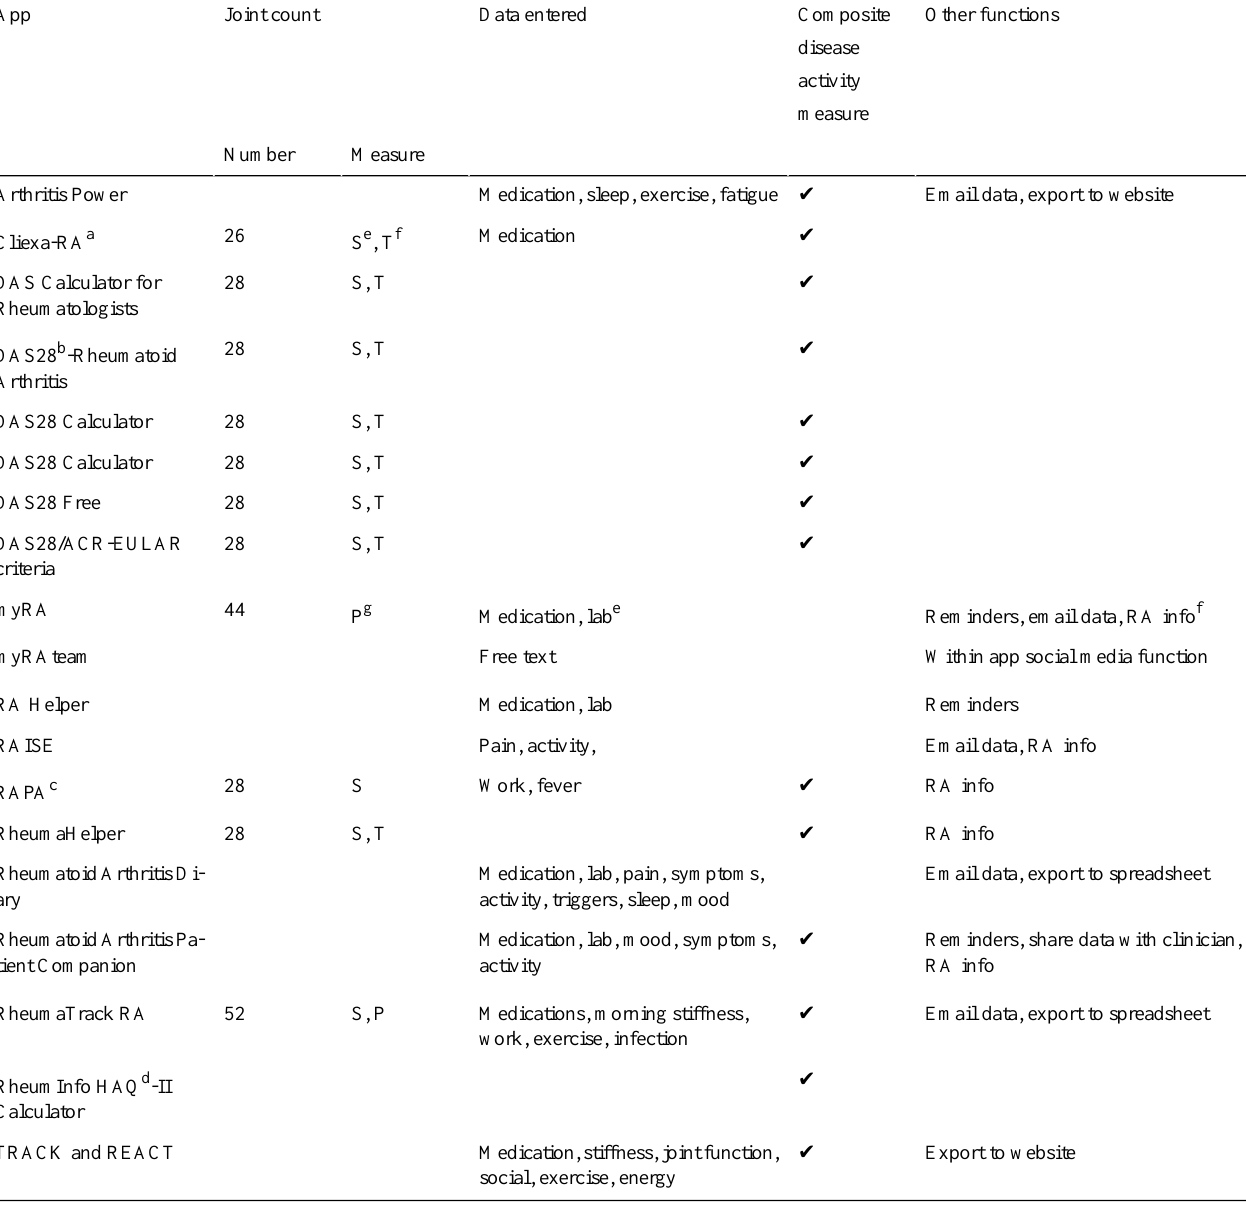
Table 4. Joint count and other functionality of included apps.